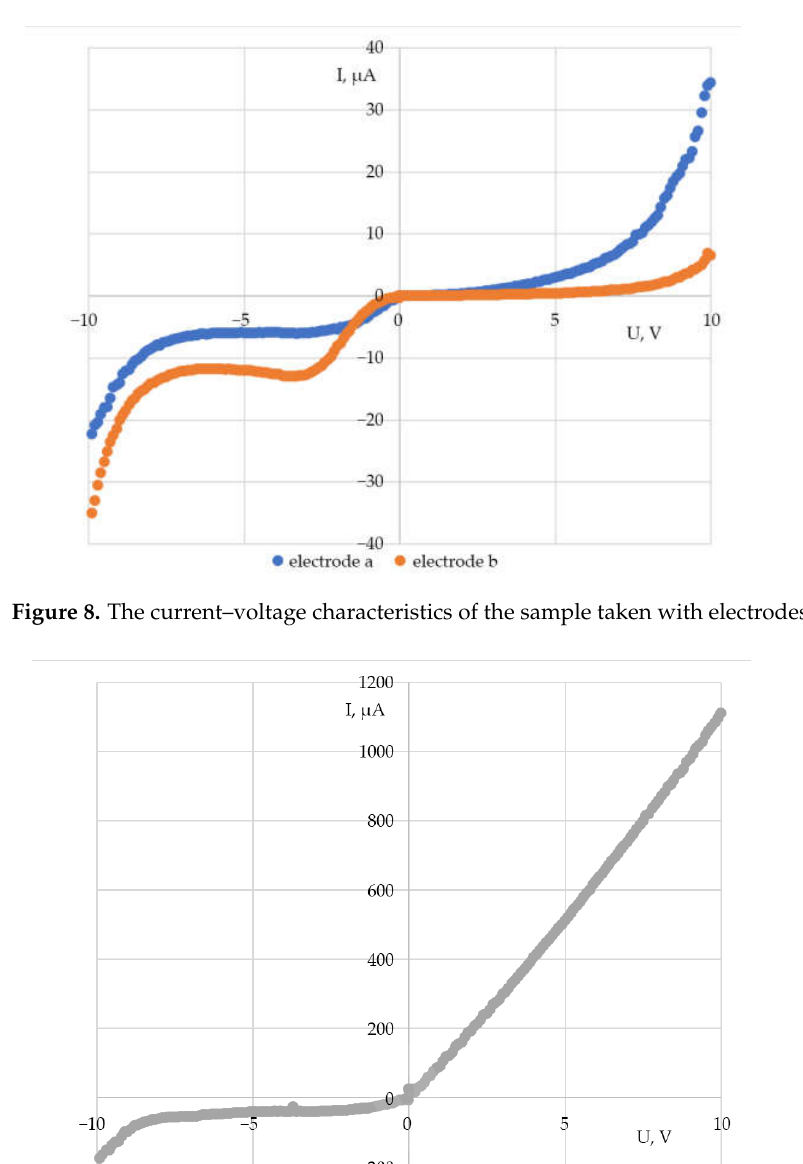
Figure 7. Various variants of the liquid electrode contact area: ( a )—contact area diameter d = 40 µm; ( b )—contact area diameter d = 80 µm; ( c )—diameter of the contact area d = 120 µm.